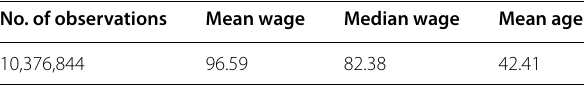
Table 6 Summary statistics SIAB-Pure 2